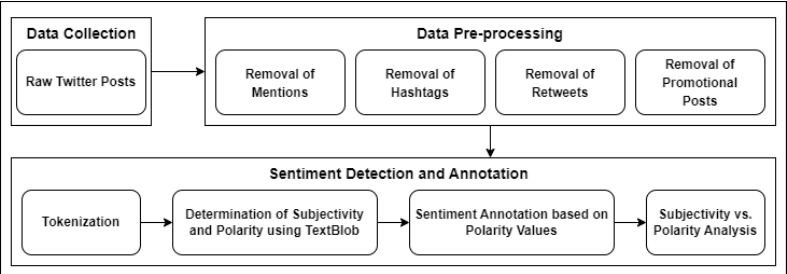
Figure 4. Overview of proposed mechanism for sentiment detection and